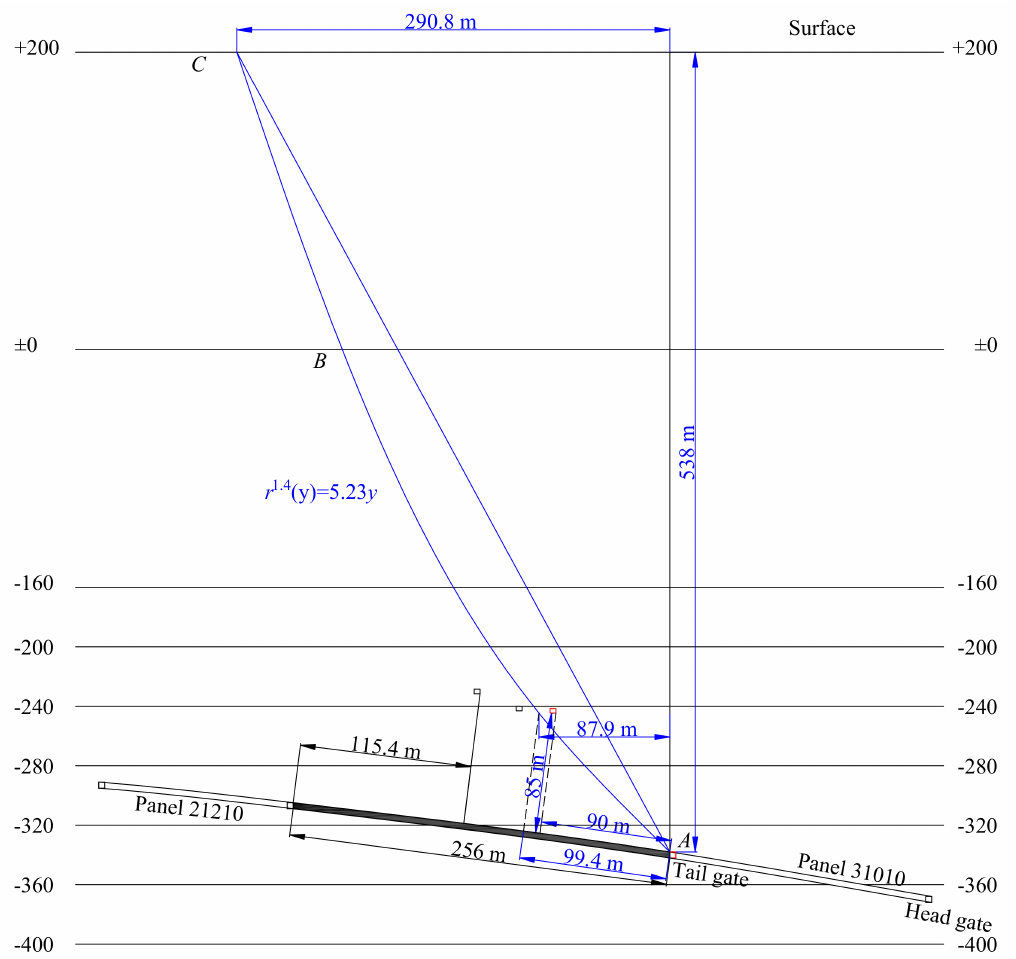
Figure 15. The width of the protective coal pillar for passenger roadway designed according to strata movement